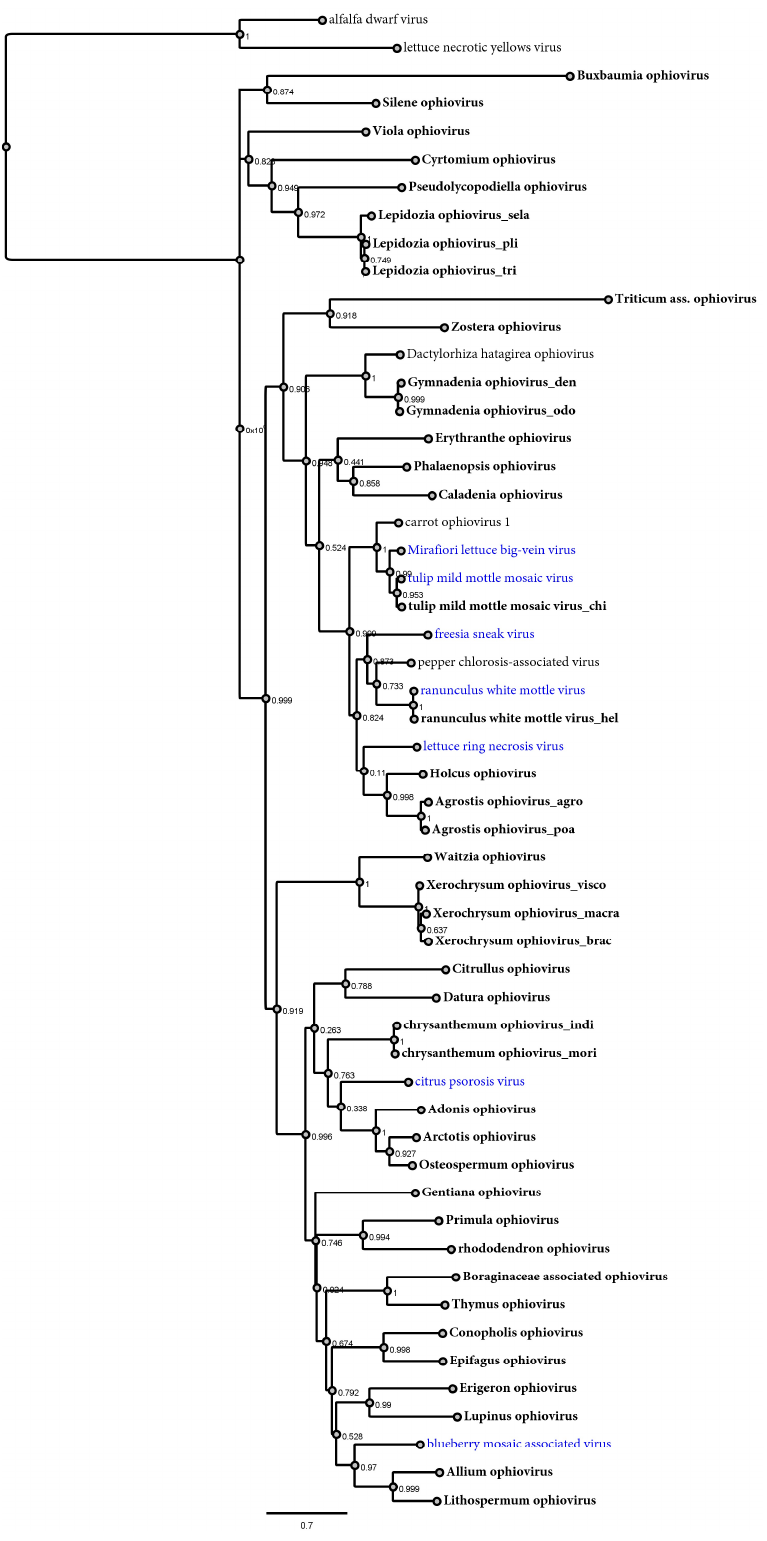
Figure 2. Maximum-likelihood phylogenetic tree based on the amino acid MAFFT sequence align- ments of the CP protein of all the ophioviruses reported thus far and in this study. The scale bar indicates the number of substitutions per site. The node labels indicate FastTree support values. The CP proteins of two cytorhabdoviruses (alfalfa dwarf virus YP_009177015 and lettuce necrotic yellows virus YP_425087) were used as outgroups. Viruses corresponding to members of ICTV-recognized species are depicted in